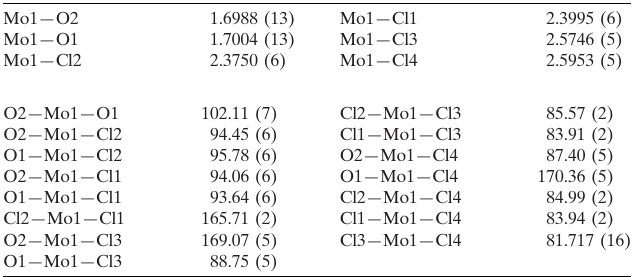
Selected geometric parameters (A˚ , (cid:5) ).